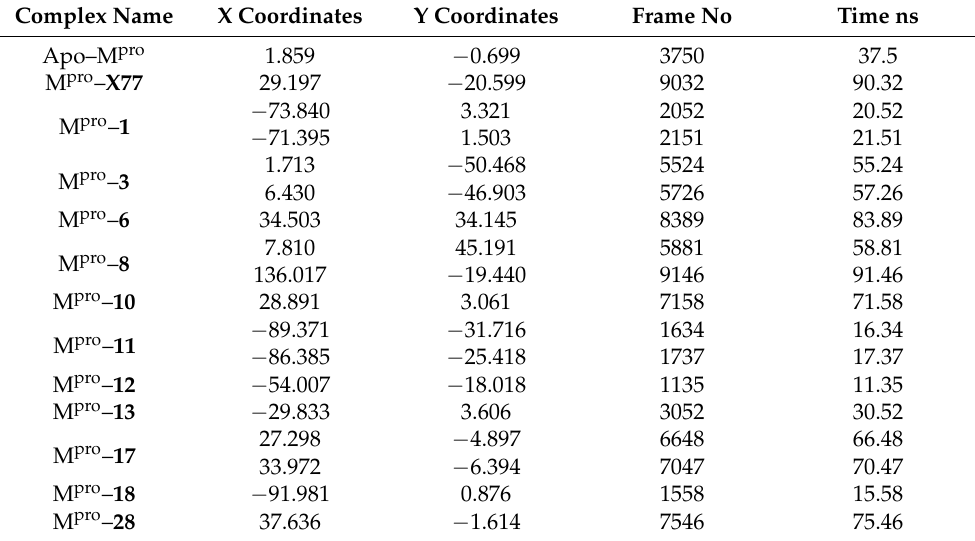
Figure 7. The free energy landscape (FEL) of free state and inhibited states is shown. High and low energy states are shown in distinct colors in the plot. The minimal, intermediate, and the high energy states are presented in dark blue, yellow, and red, respectively. The time of the metastable states (ns) and frame number is presented in green and purple, respectively. The metastable states and the native structures of M pro are depicted in cartoon model in blue and red, respectively. Table 1. The X and Y coordinates of metastable states with frame number and time (ns).